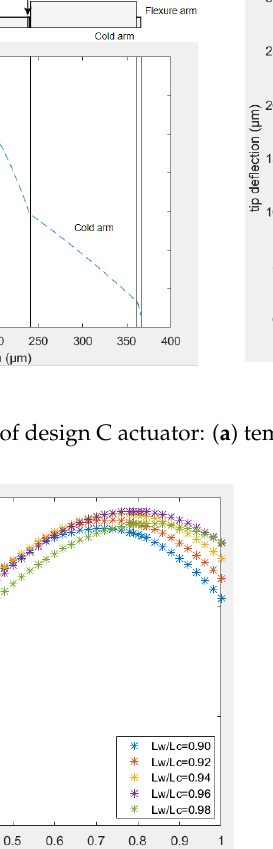
wider arm portion in the cold arm.